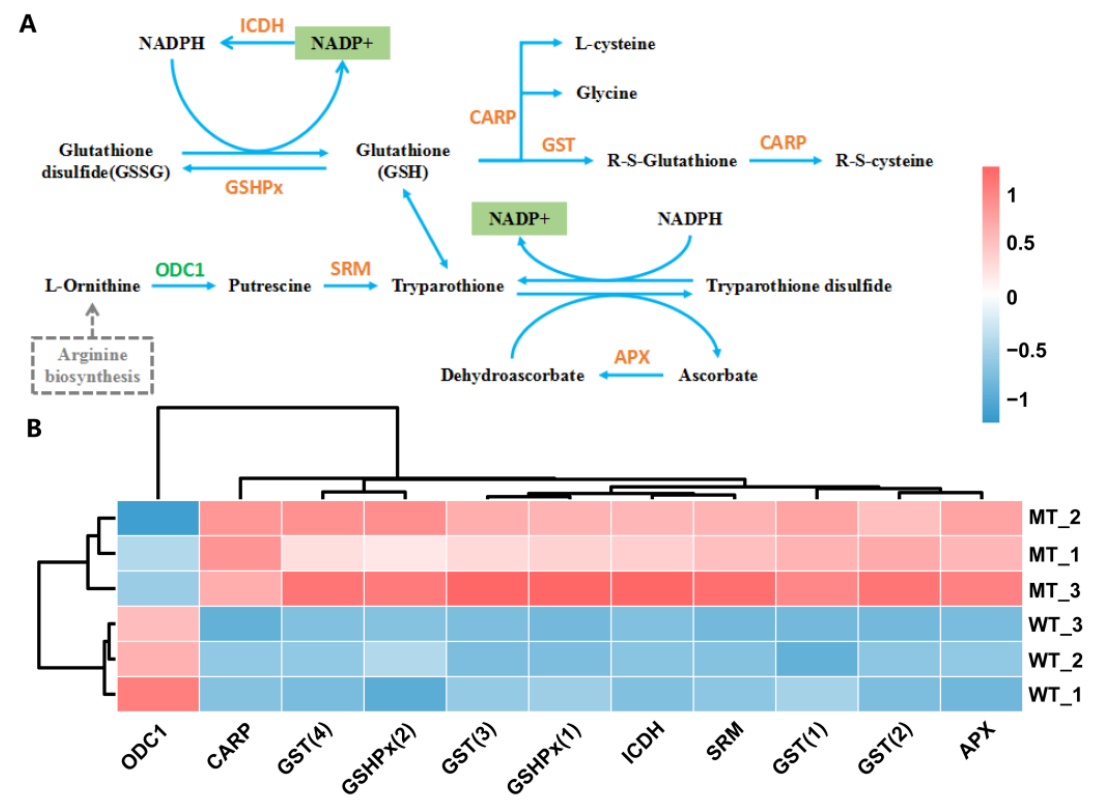
Figure 10. Glutathione metabolism pathway ( A ) and relative expression level of DEGs ( B ). GST, glutathione S-transferase; CARP, leucine aminopeptidase; ICDH, cytosolic isocitrate dehydrogenase [NADP]; APX, L-ascorbate peroxidase; GSHPx, phospholipid hydroperoxide glutathione peroxidase; SRM/SPE, spermidine synthase; ODC1, ornithine decarboxylase. The analyses used WT as a control.